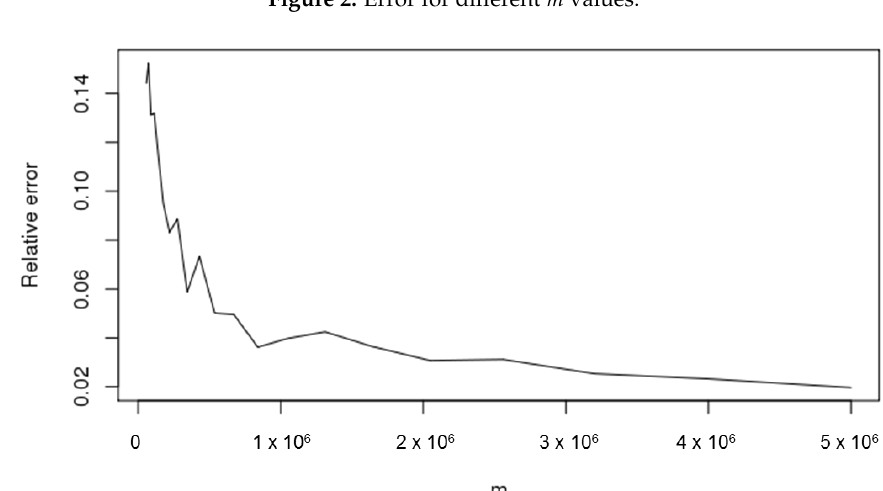
Figure 2. Error for different m values.